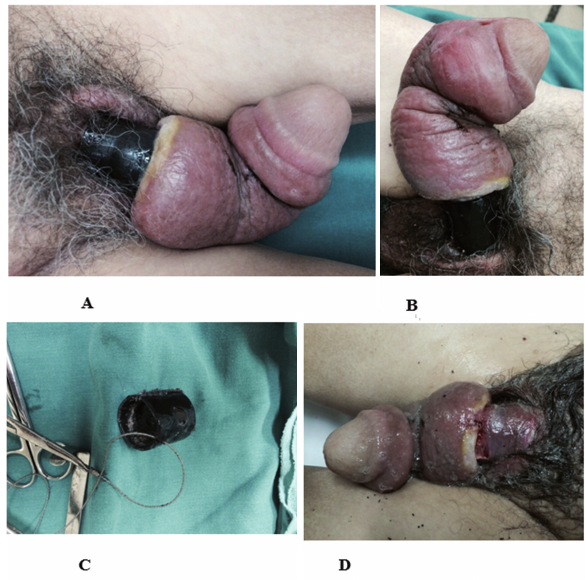
(B).Figure 3 - Patient with penile incarceration produced by plastic tube (A+B). Gigli saw used to remove the foreign body (C). Final appearance of the penile shaft after penile constrictor removal